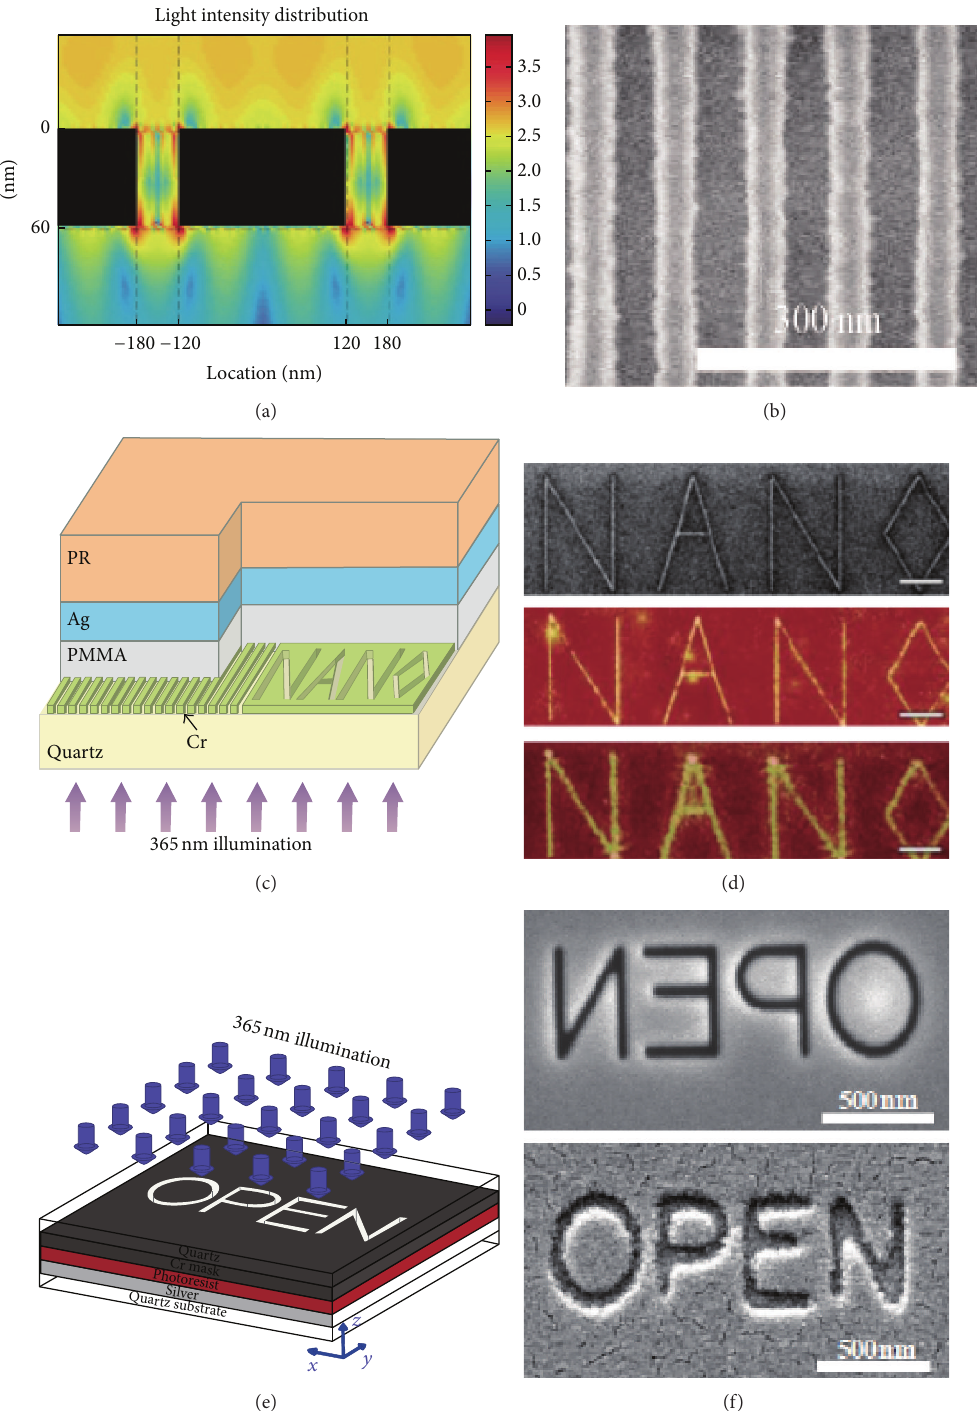
Figure 20: Experimental demonstration of near-sighted silver lens. (a) Numerical simulation of intensity distribution of surface plasmons. (b) SEM image of resist pattern for (a). (c) Schematic diagram of the silver superlens experiment. (d) (Top) Focused-ion-beam image of the object with 40 nm line width, (middle) AFM images of topographic characterization in resist layer with a silver superlens, and (bottom) AFM images of topographic characterization in resist layer with the 35 nm thick superlens replaced by PMMA spacer as a control experiment. (e) Schematic of imaging lithography structure with a reflective Ag lens. (f) (Top) SEM image of the mask pattern “OPEN” characters, (bottom) SEM image of resist pattern. SEM image of half-pitch 32 nm dense lines resist pattern with plasmonic cavity lens. AFM image of half-pitch 22 nm resist pattern. Inset shows its two-dimensional (2D) Fourier analysis diagram. Figures are reproduced from (a, b) [31], (c, d) [30], and (e, f)